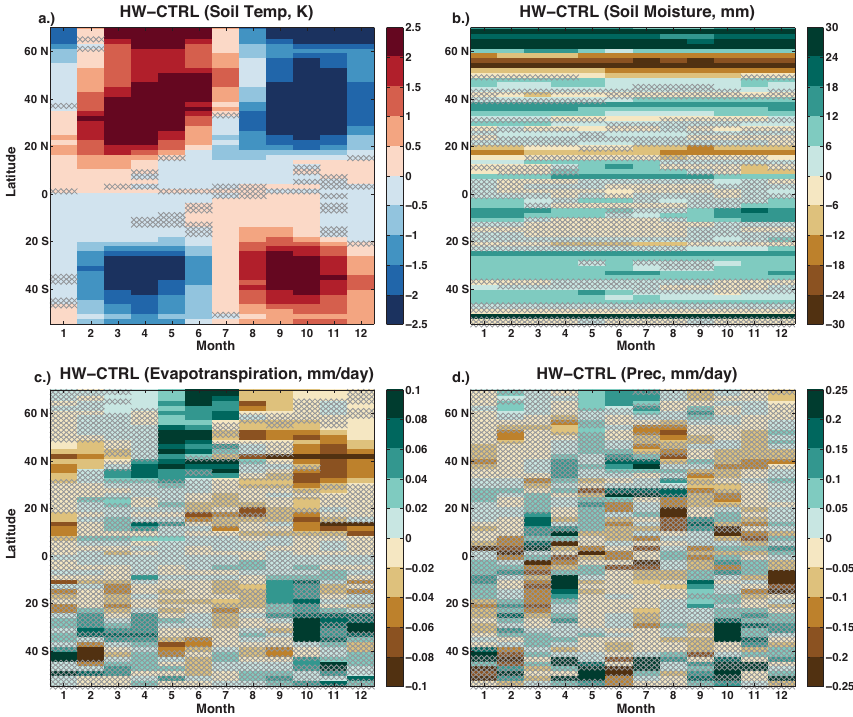
Fig. 3. Month-latitude climatologies, Aquifer minus Control run. (a) Soil temperature. (b) Soil moisture. (c) Evaporation. (d) Precipitation. Differences not significant at the 0.05 level are